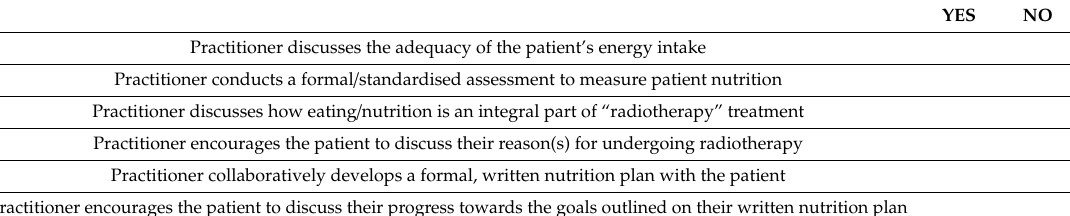
Table 1. Study Specific Fidelity